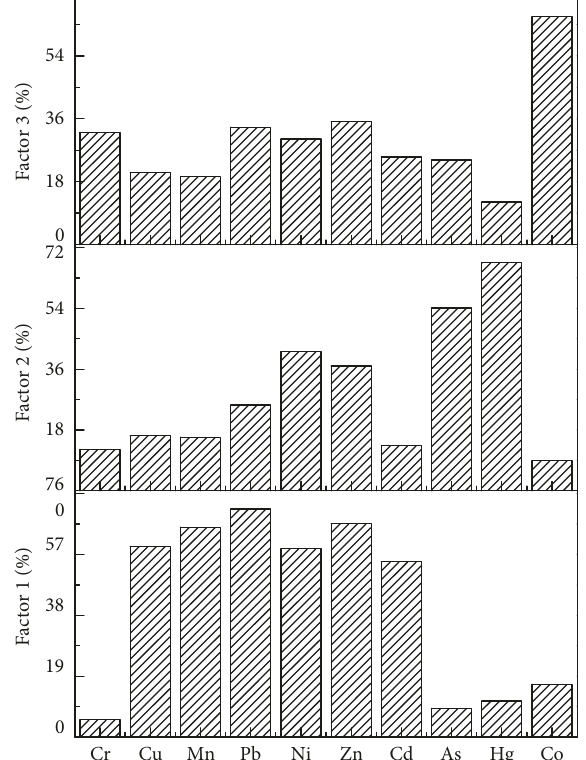
Figure 6: Analytical contributions of soil heavy metals PMF sources.